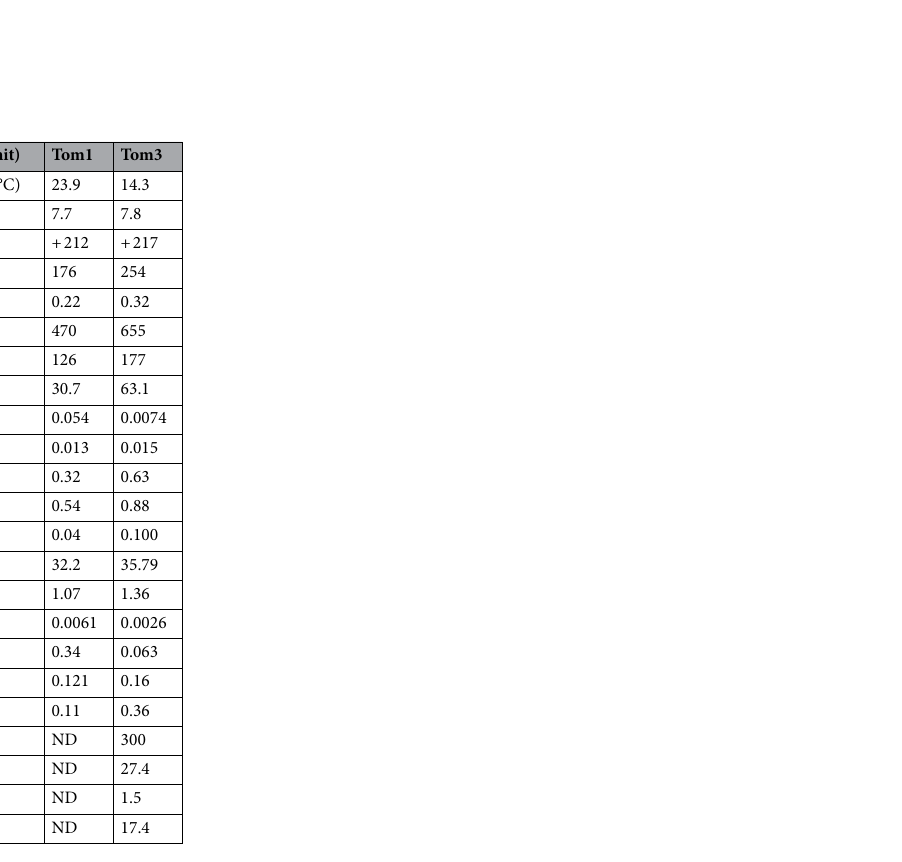
Table 1. Physical and chemical characteristics of the pore water from the solid–liquid separation lagoon (Tom1) and manure storage lagoon (Tom3). ND not determined.